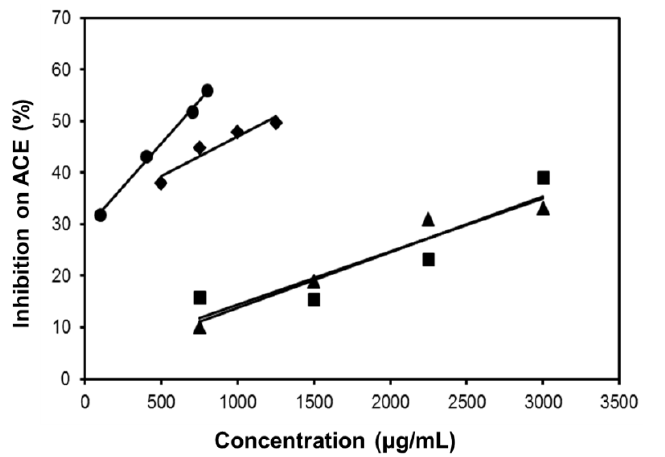
Figure 7. Inhibitory activities of S. orientalis extracts on ACE. ( ● ) SE-EA; ( ♦ ) SE; ( ■ ) SE-Hex; and ( ▲ ) SE-MeOH.